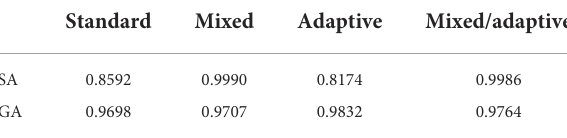
TABLE 1 Summary of peak average fitness between all four SA and GA cases on the 5D Ackley benchmark